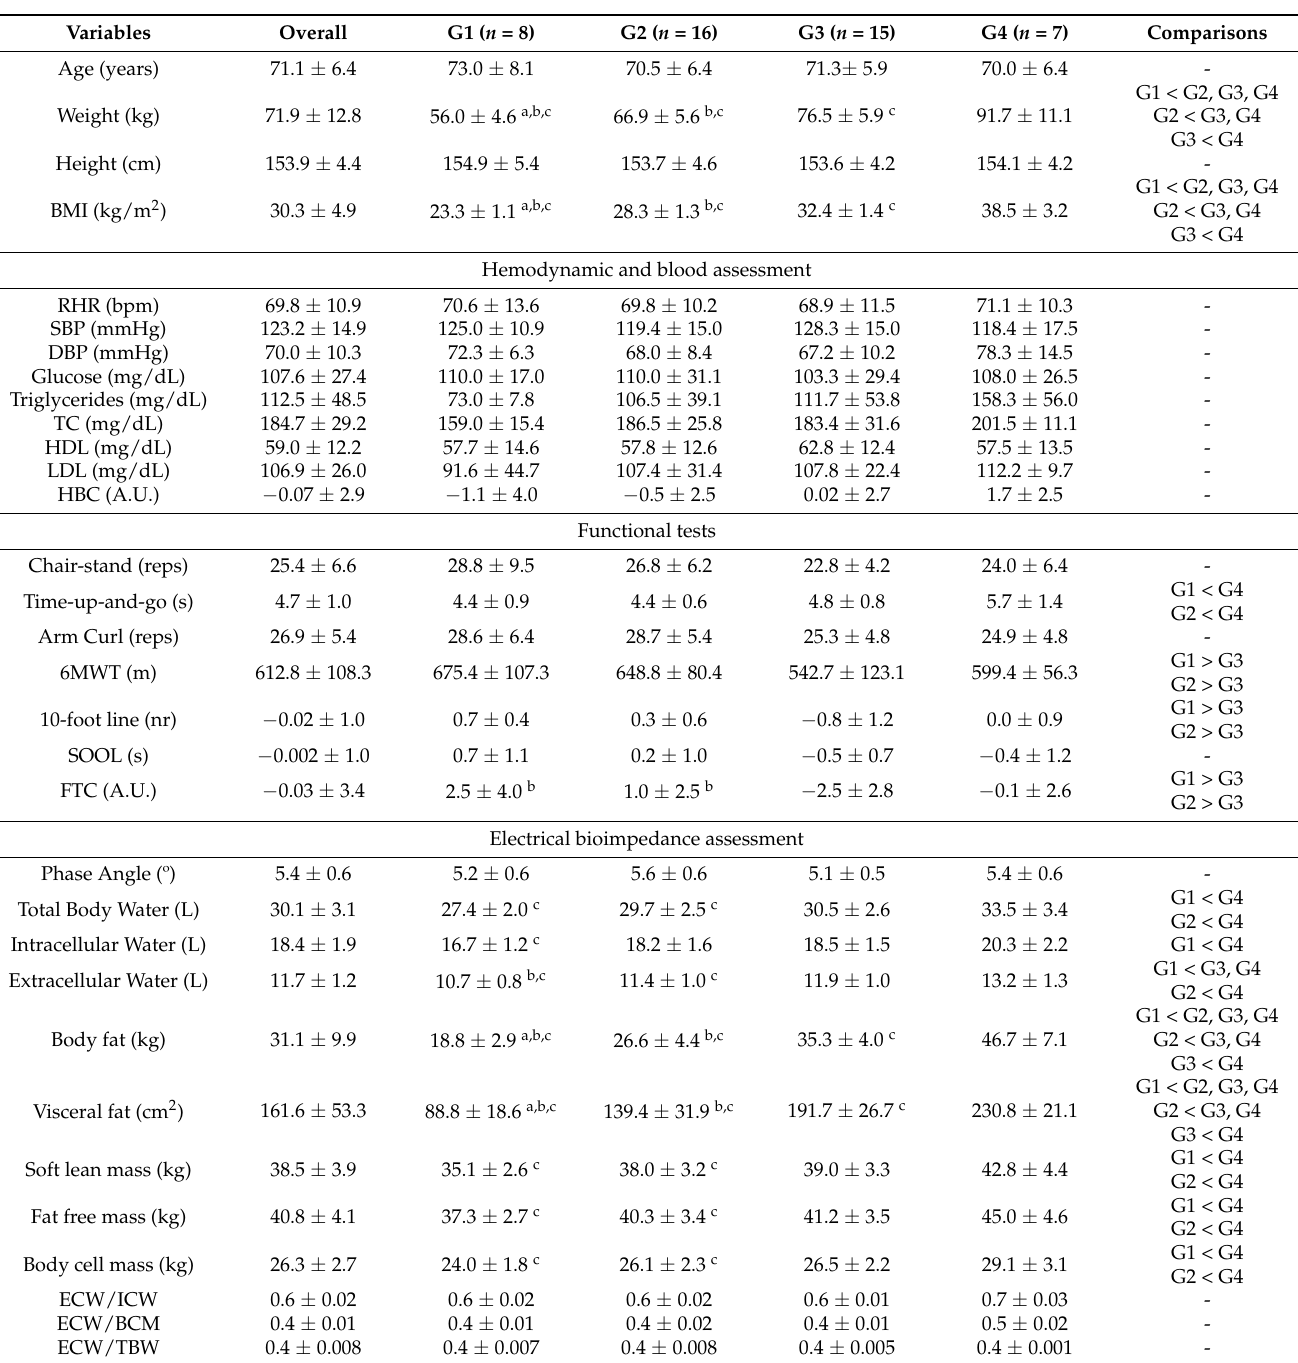
Table 1. Descriptive (mean ± SD) and comparative statistics of anthropometric and biochemical characteristics between all groups for all